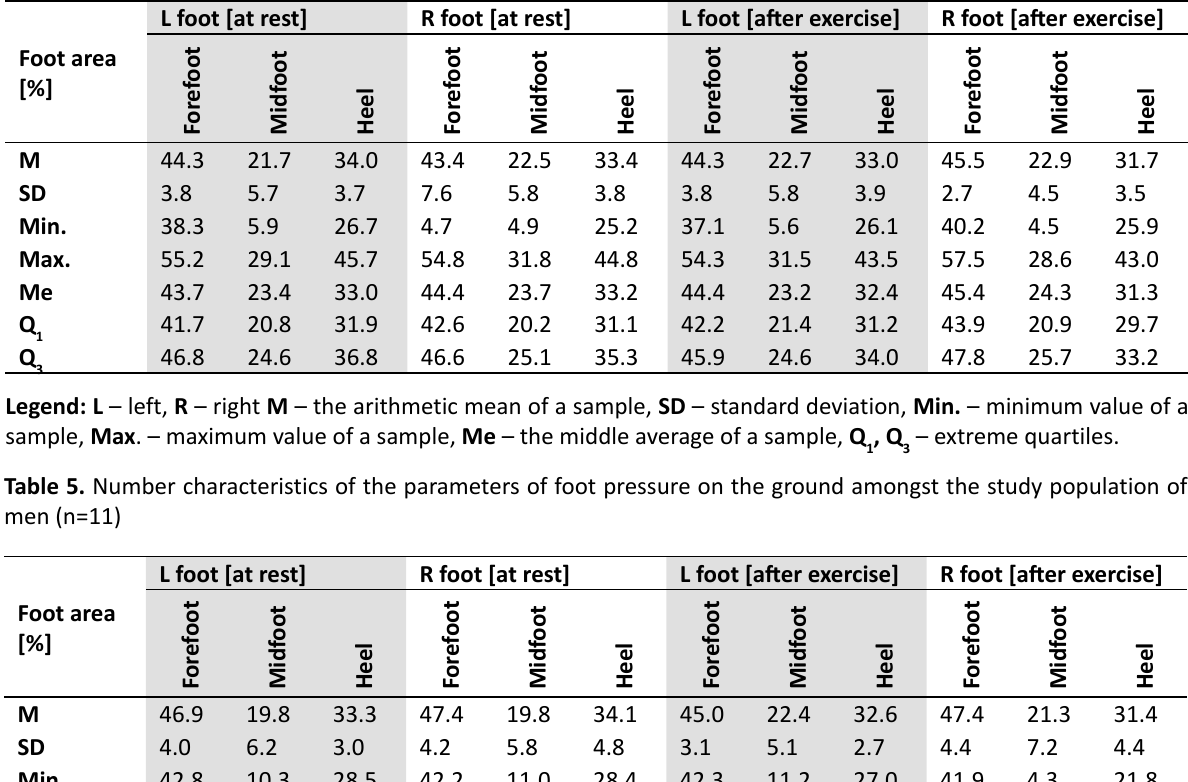
Table 4. Number characteristics of the parameters of foot pressure on the ground amongst the study population of women (n=37) L foot [at rest] Foot area [%]